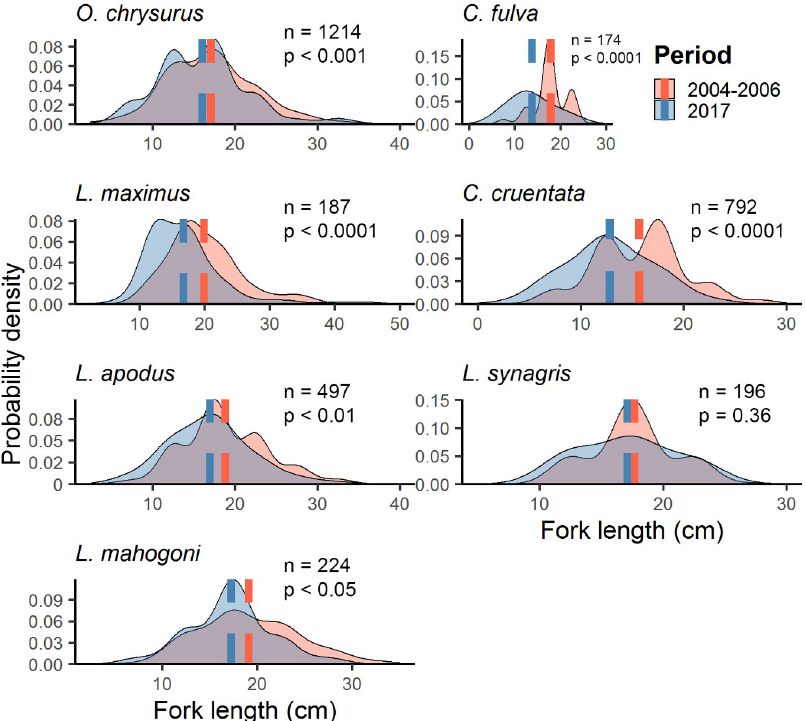
Fig 9. Probability density distributions of estimated fork length of commercial species from the LPNR. Mean fork length for yellowtail snapper ( O . chrysurus ), coney ( C . fulva ), hogfish ( L . maximus ), graysby ( C . cruentata ), schoolmaster ( L . apodus ), lane snapper ( L . synagris ) and mahogany snapper ( L . mahogoni ), and p values from Mann- Whitney U tests of mean rank